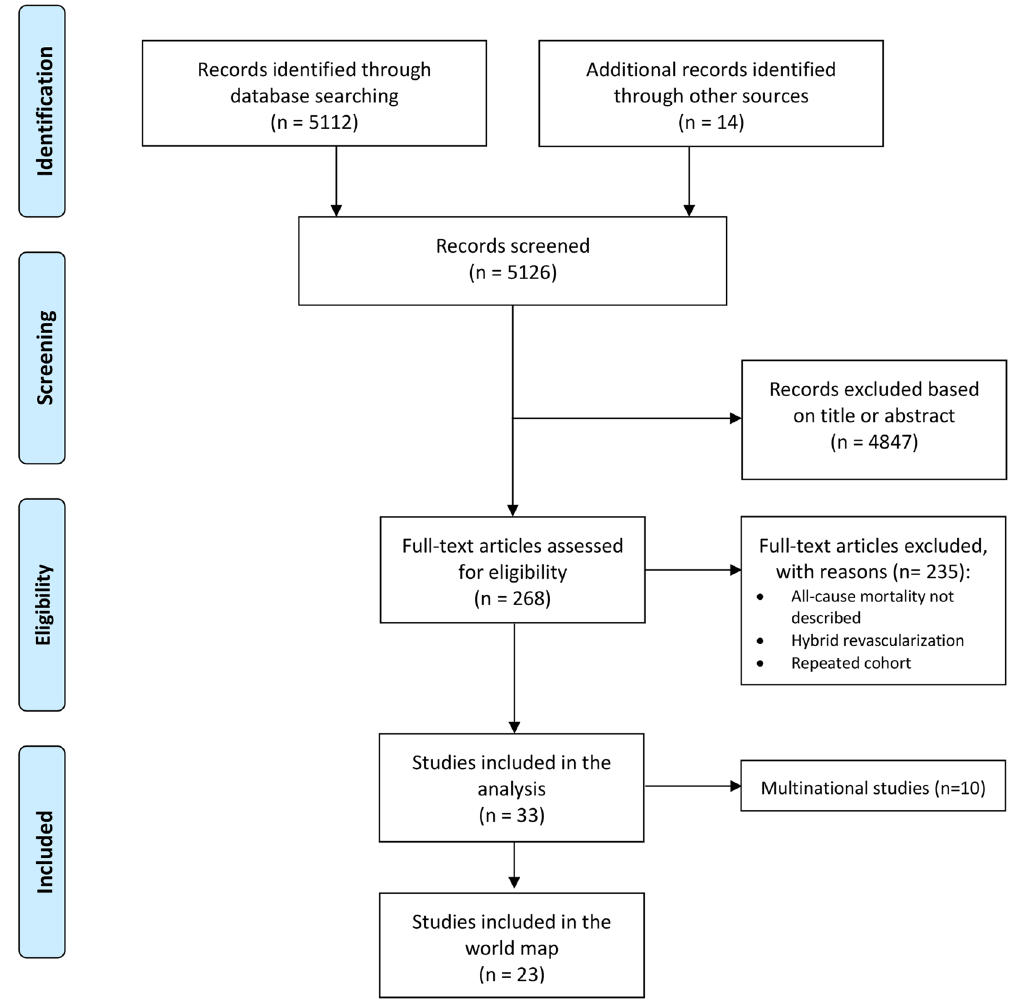
Figure 1. PRISMA diagram describing the systematic research, inclusion/exclusion criteria and the study